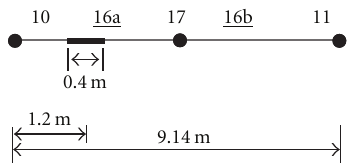
Figure 2: Identification of less severe defect more